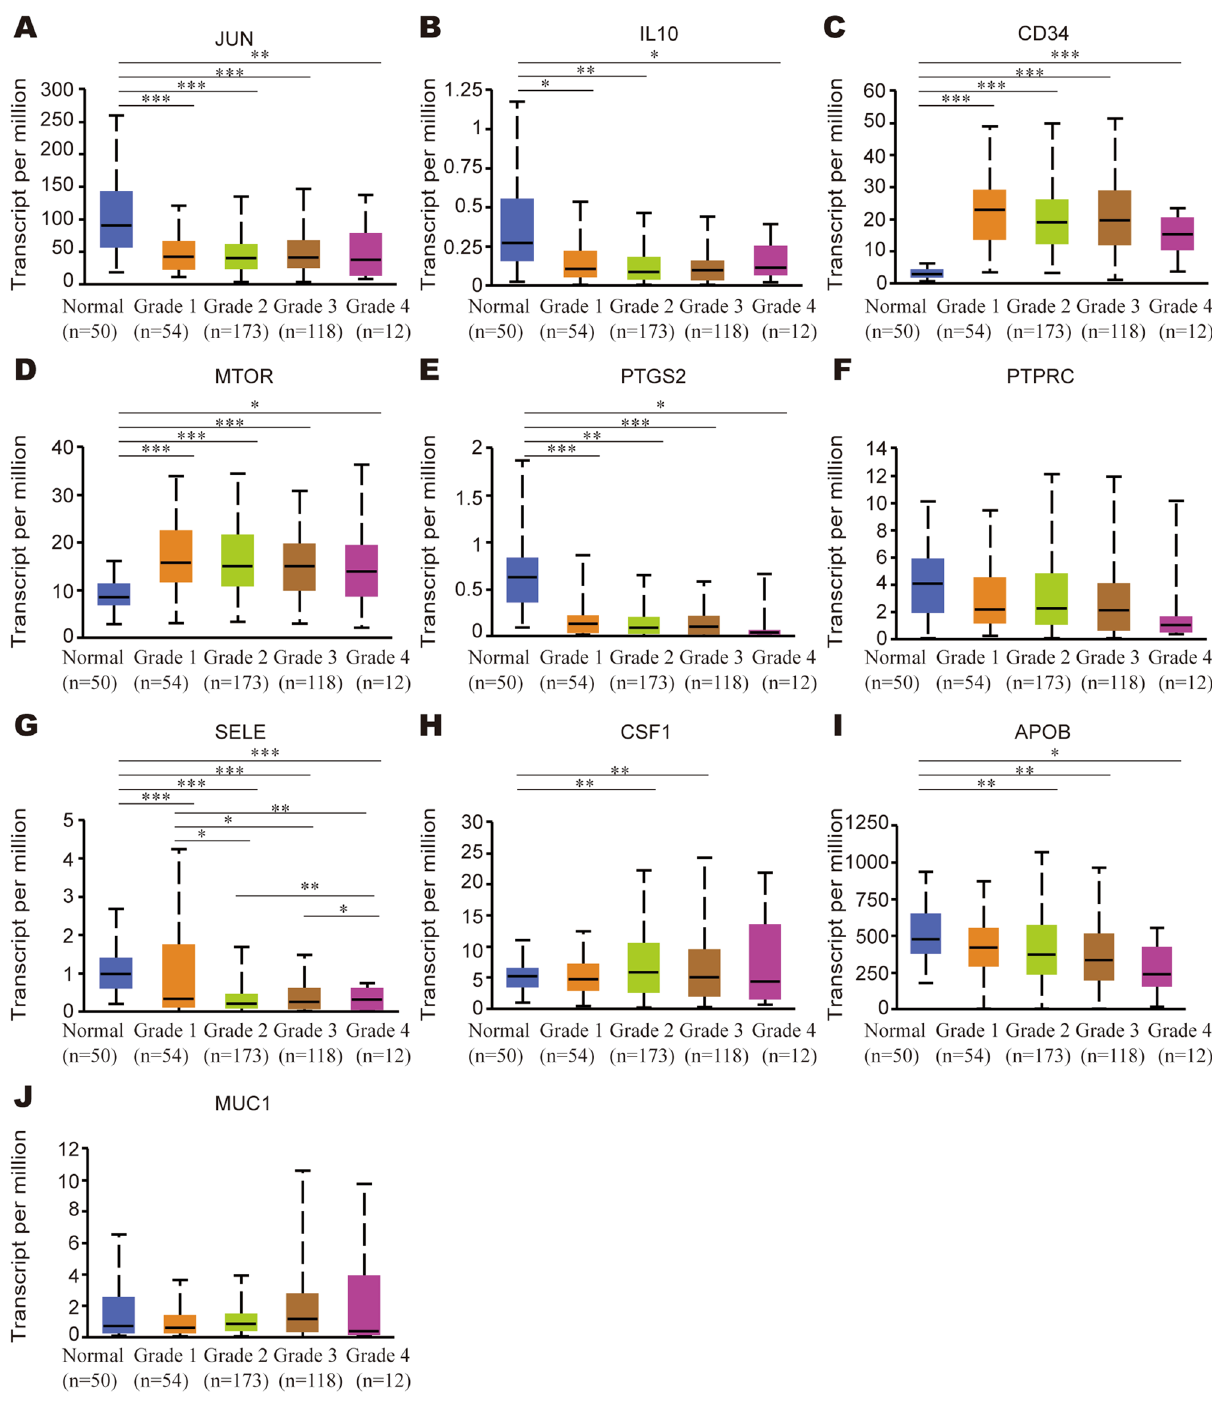
Figure 7. Association of mRNA expression of hub genes with tumor grades of HCC patients. ( A ) JUN, ( B ) IL10, ( C ) CD34, ( D ) MTOR, ( E ) PTGS2, ( F ) PTPRC, ( G ) SELE, ( H ) CSF1, ( I ) APOB, ( J ) MUC1. *P < 0.05, **P < 0.01, ***P <